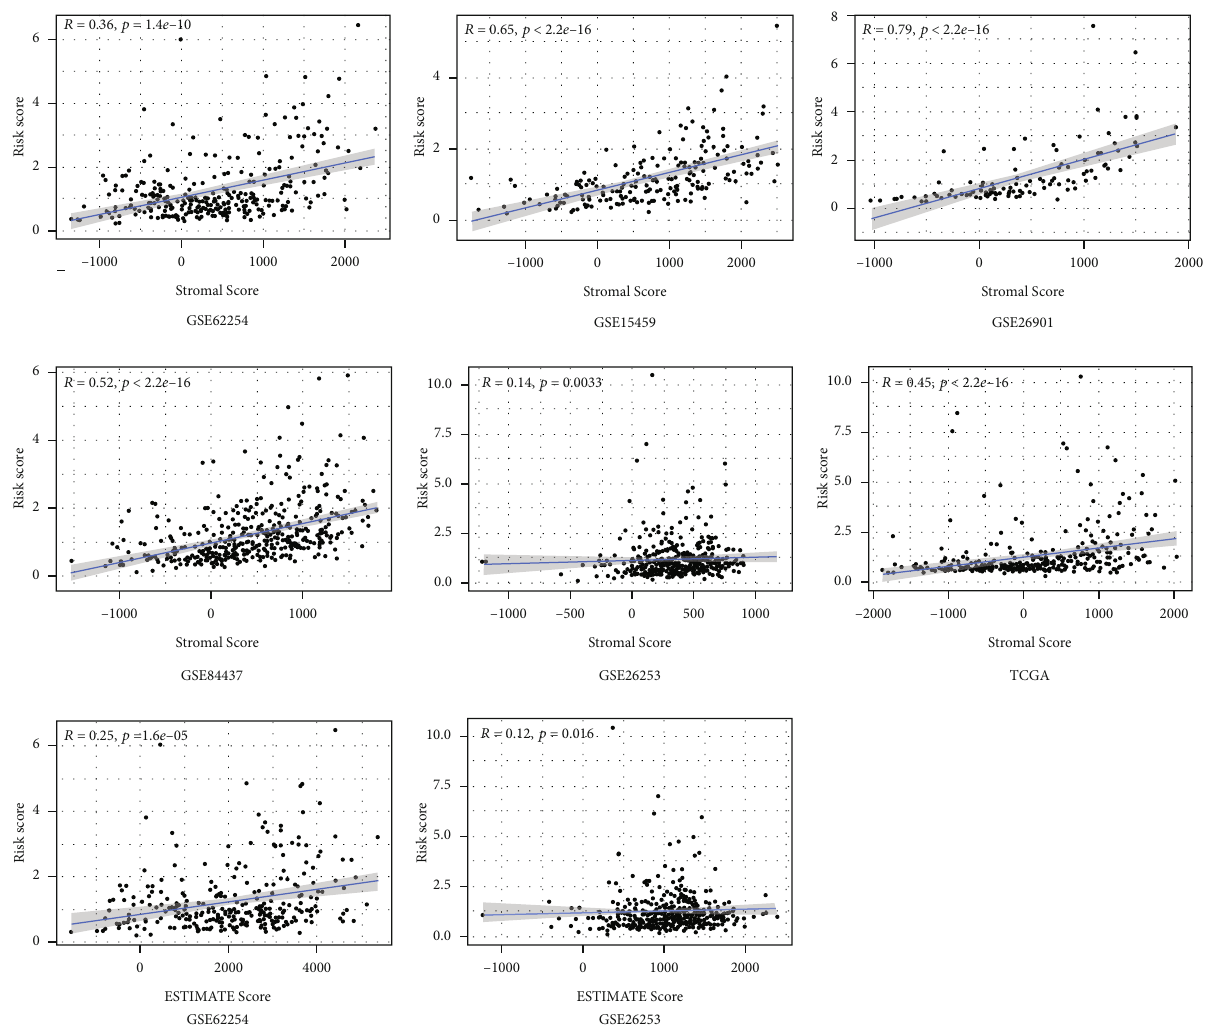
Figure 11: The association between risk score and the Stromal Score, Immune Score, and ESTIMATE